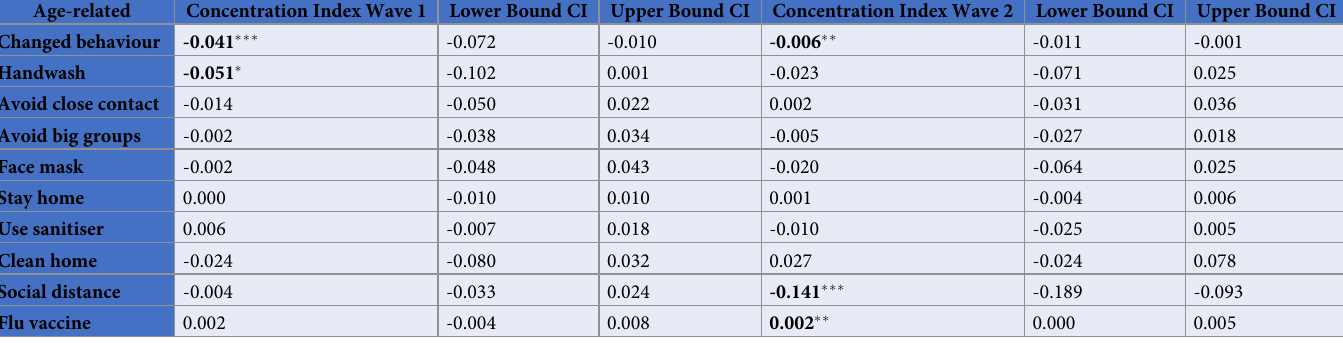
Table 4. Erreygers’-corrected concentration index (age-related) of preventive measures.